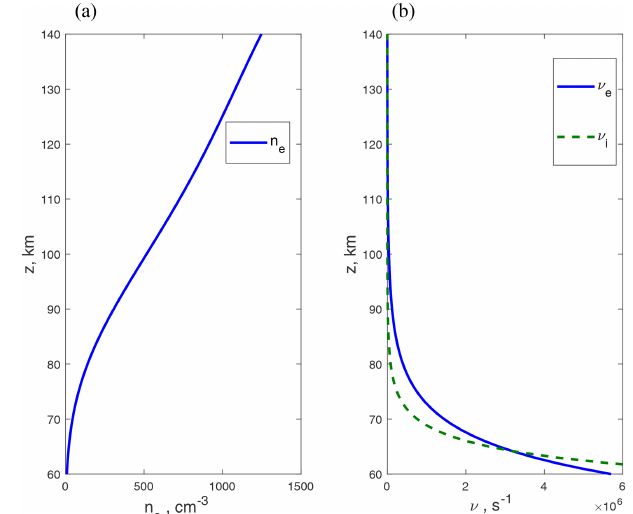
Figure 2. Fields in the z = 0 plane: (a) characteristic horizon- tal sizes of the horizontal magnetic field, (b) the electric field at the height z = 125km, (c) the polarization ellipse parameters (cid:16) (cid:17) (cid:12) (cid:12) φ E y (cid:48) = E x (cid:48) e iφ , and (d) log (cid:12) E y (cid:48) /E x (cid:48) (cid:12) .